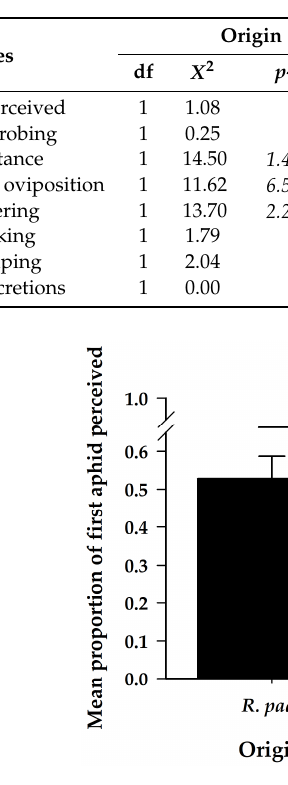
Figure 1. Mean proportion ( ± SE) of first aphid perceptions by A. platensis from two origins ( R. padi and M. persicae) exposed to these aphid hosts in a paired arena. Asterisks indicate significant di ff erences: ‘ns’ non-significant p >